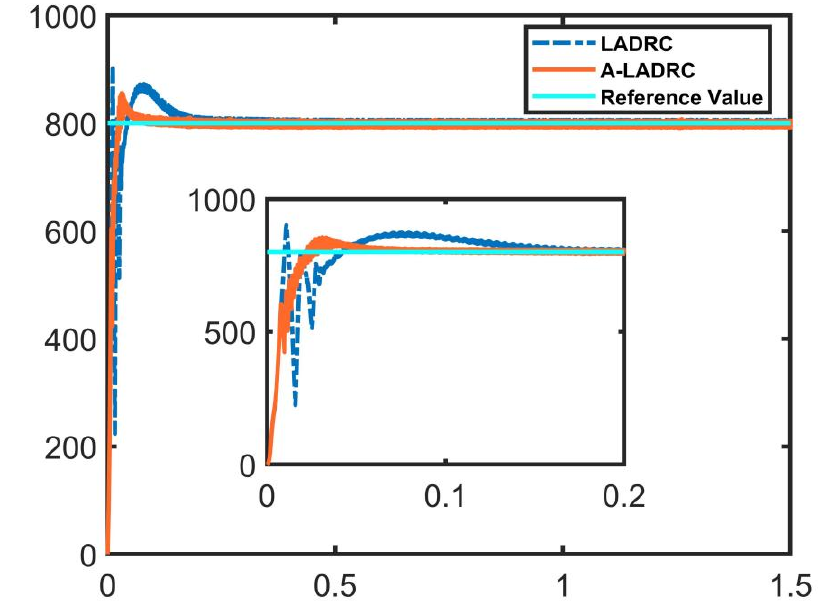
Figure 8. DC bus voltage waveform.